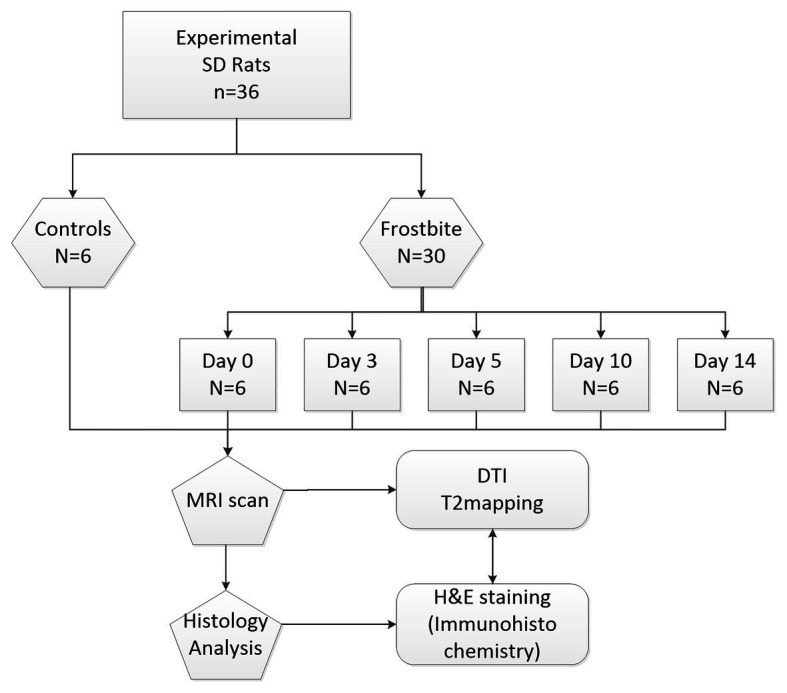
Flowchart demonstrating the study design.